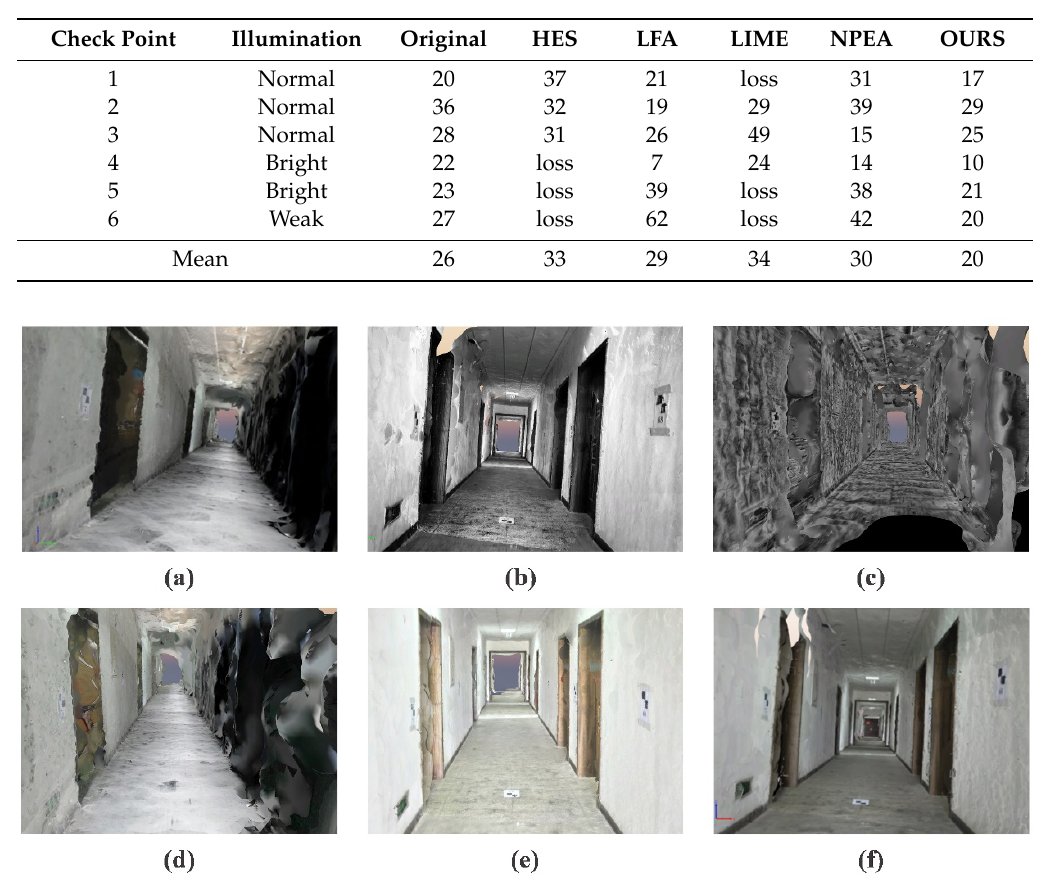
Table 7. Total error of checkpoints (mm).